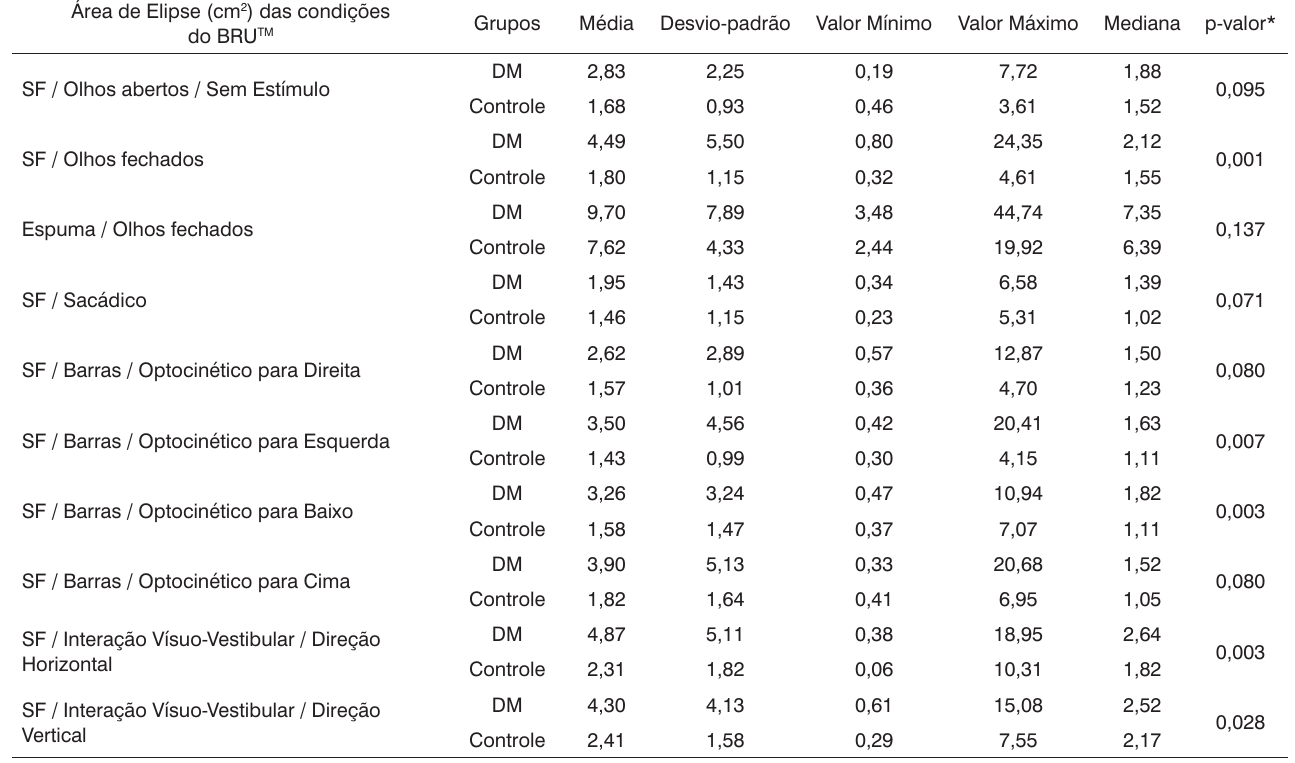
Tabela 2. Valores descritivos e análise comparativa da área de elipse (cm 2 ) das condições do Balance Rehabilitation Unit (BRU TM ) de 40 indiví- duos do grupo controle e de 30 pacientes no período intercrítico de doença de Ménière